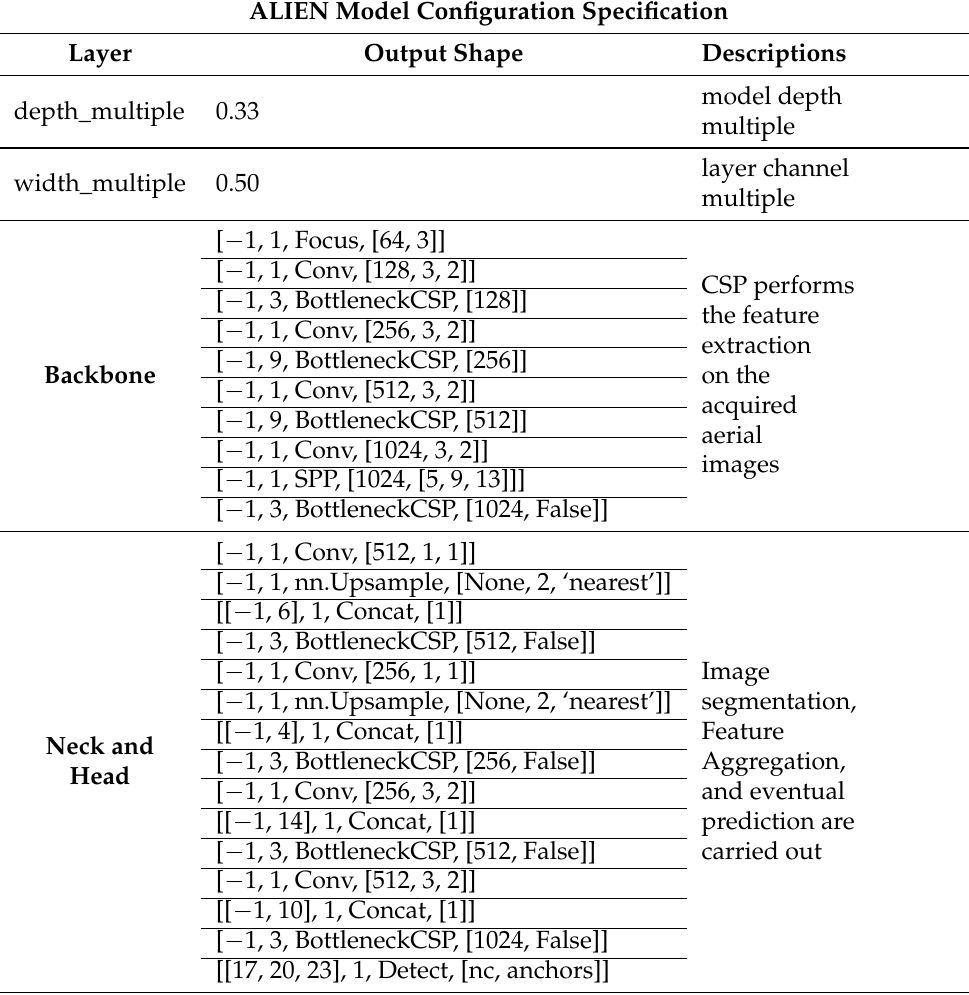
Table 1. ALIEN convolutional